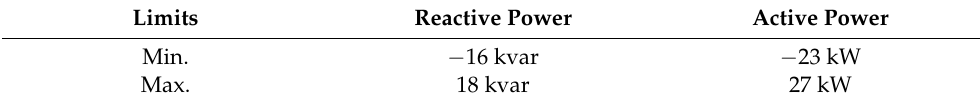
Table 1. Stability analysis—Limits of active and reactive power for stable system operation. Limits Reactive Power Active Power Min. − 16 kvar − 23 kW Max. 18 kvar 27